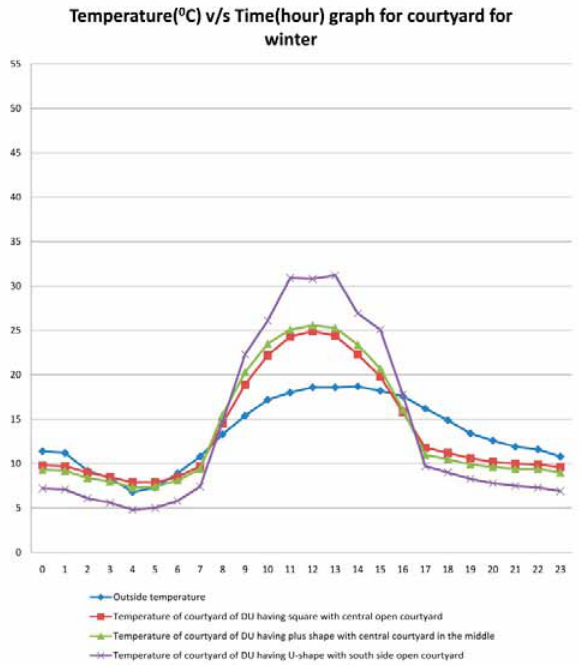
Peak winter day